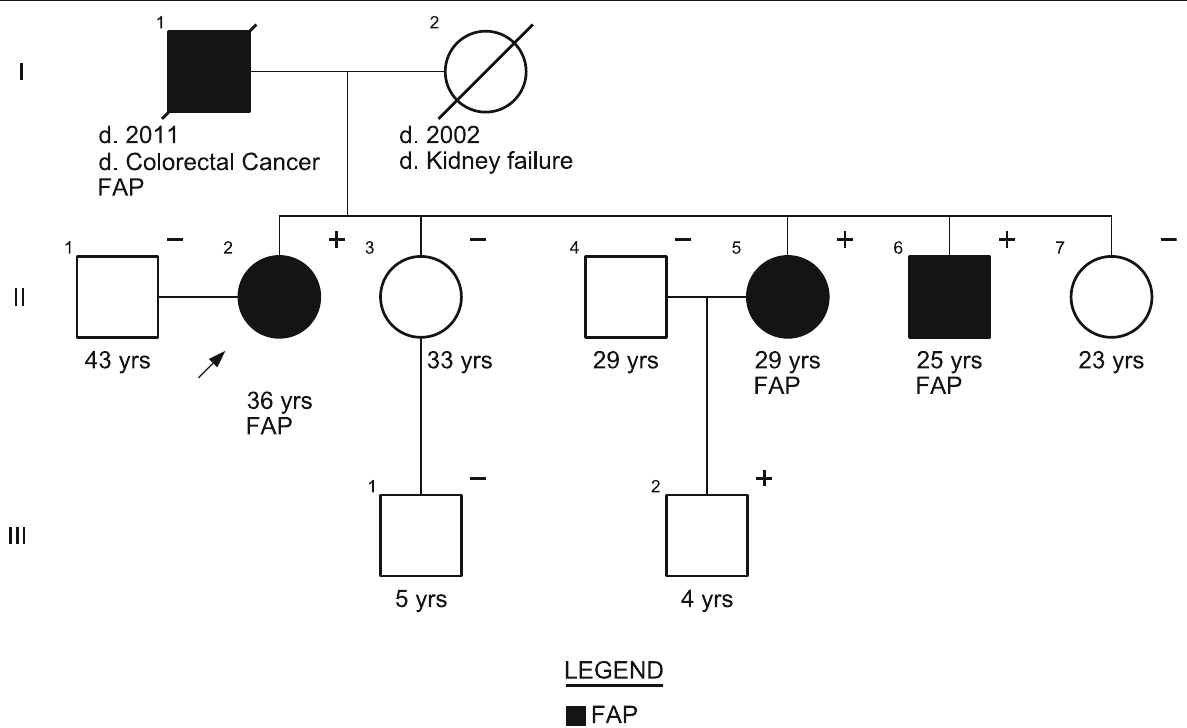
Fig. 1 Pedigree of a three-generation family with familial adenomatous polyposis. Arrow points to the proband (II-2). Shading indicates family members that were diagnosed with FAP. Squares and circles denote males and females respectively. Roman number indicates generations. Plus and minus signs indicate presence of APC